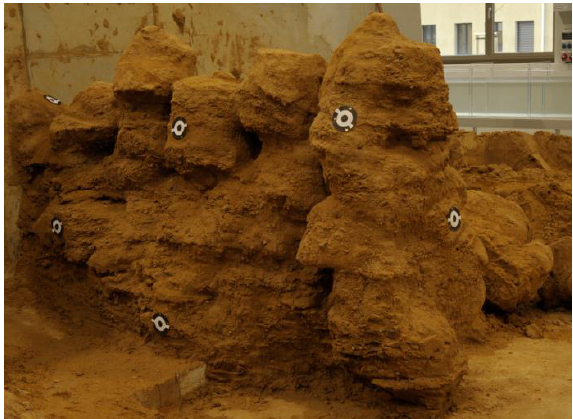
Figure 1. Picture of the remaining shapes